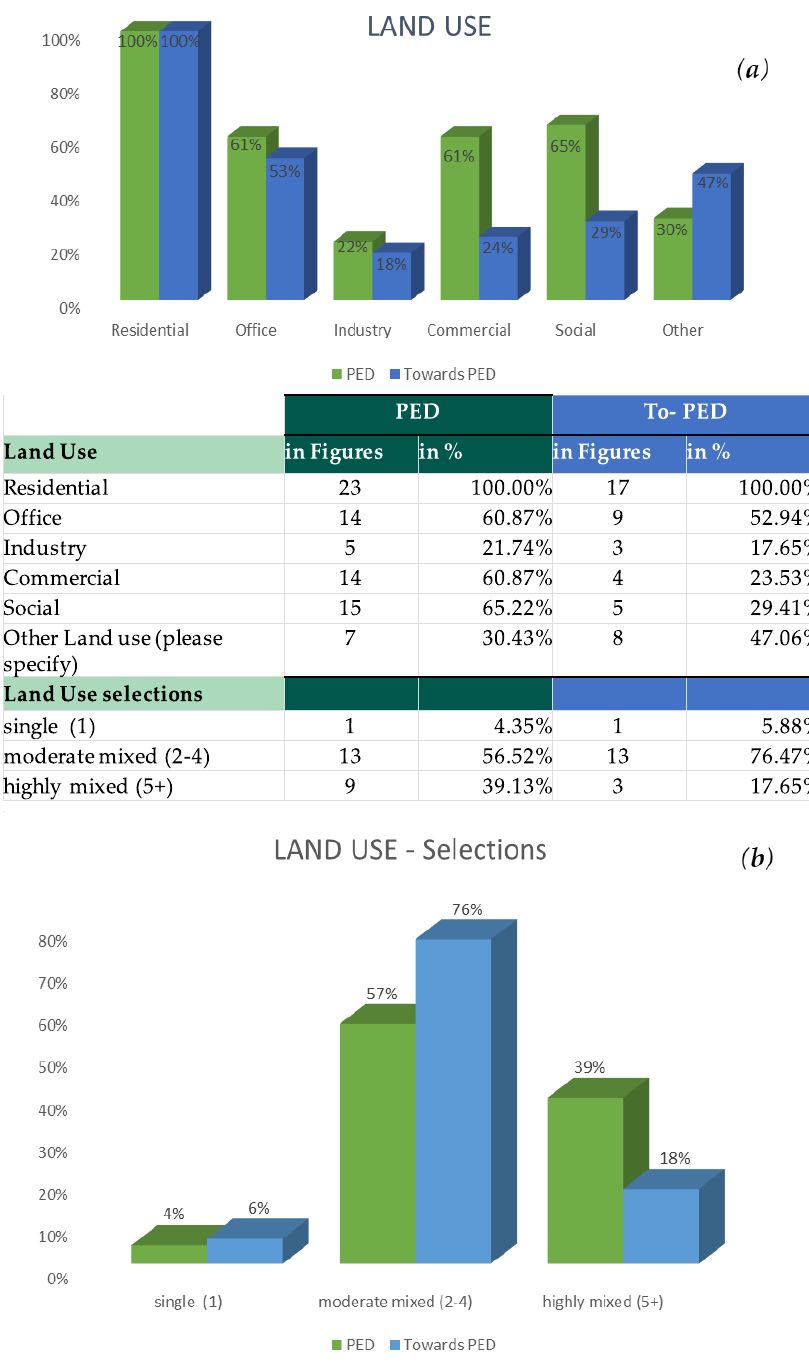
Figure 3. ( a ) Land use of PED versus To-PED; ( b ) land use selection of PEDs versus To-PED. The number of di ff erent land use selections were counted for PED and Towards PED